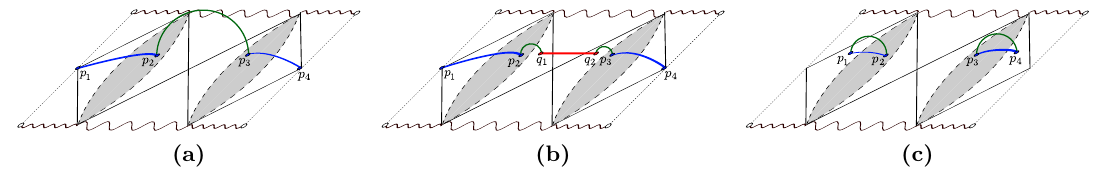
Figure 10. Configurations of the RT geodesics extending into the 3d bulk which determine the competing generalized entropy channels with the second black hole included in the region being probed. The drawings are identified across the dashed line which goes through the bifurcation surface of the second black hole. Multiple-island configurations, which turn out to be always subleading, are not shown. For the connected configurations (a) and (b) the blue segments join across the bifurcation surface and the QES is empty